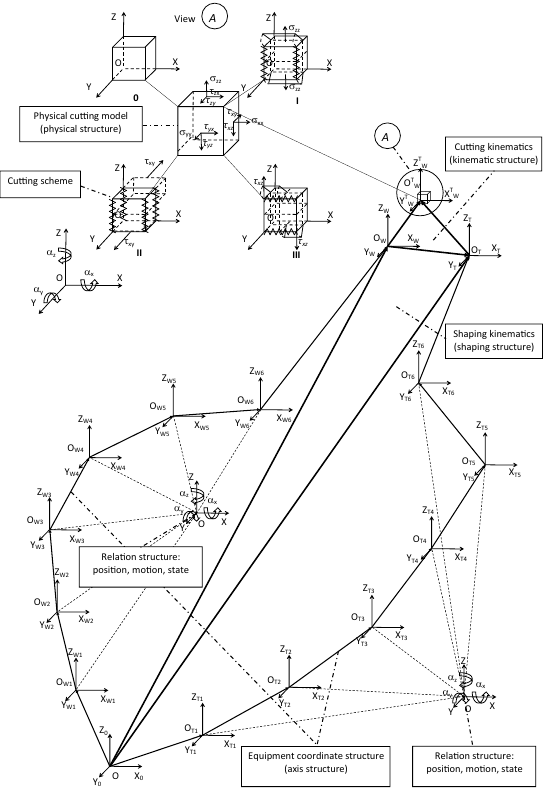
Fig. 3. Process and equipment model for material machining by